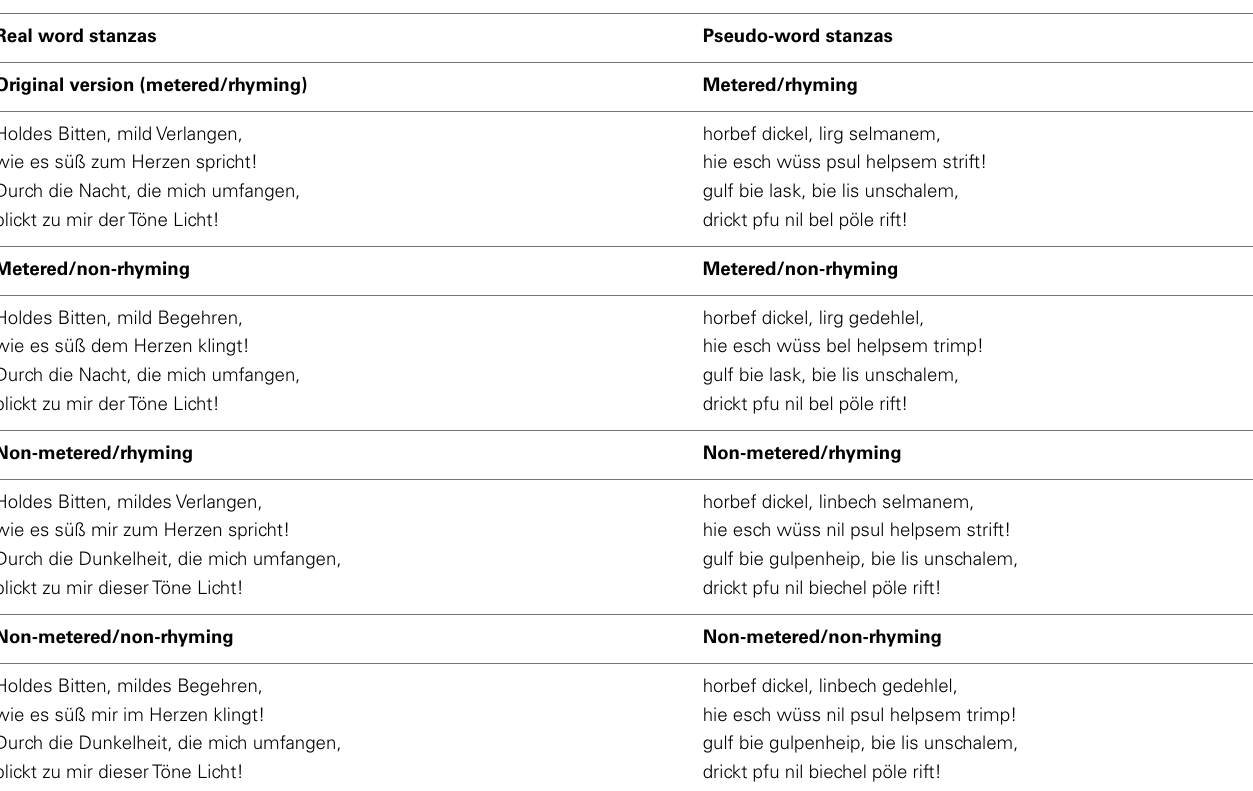
Table 1 | Stimulus examples (Brentano, 1803: Abendständchen